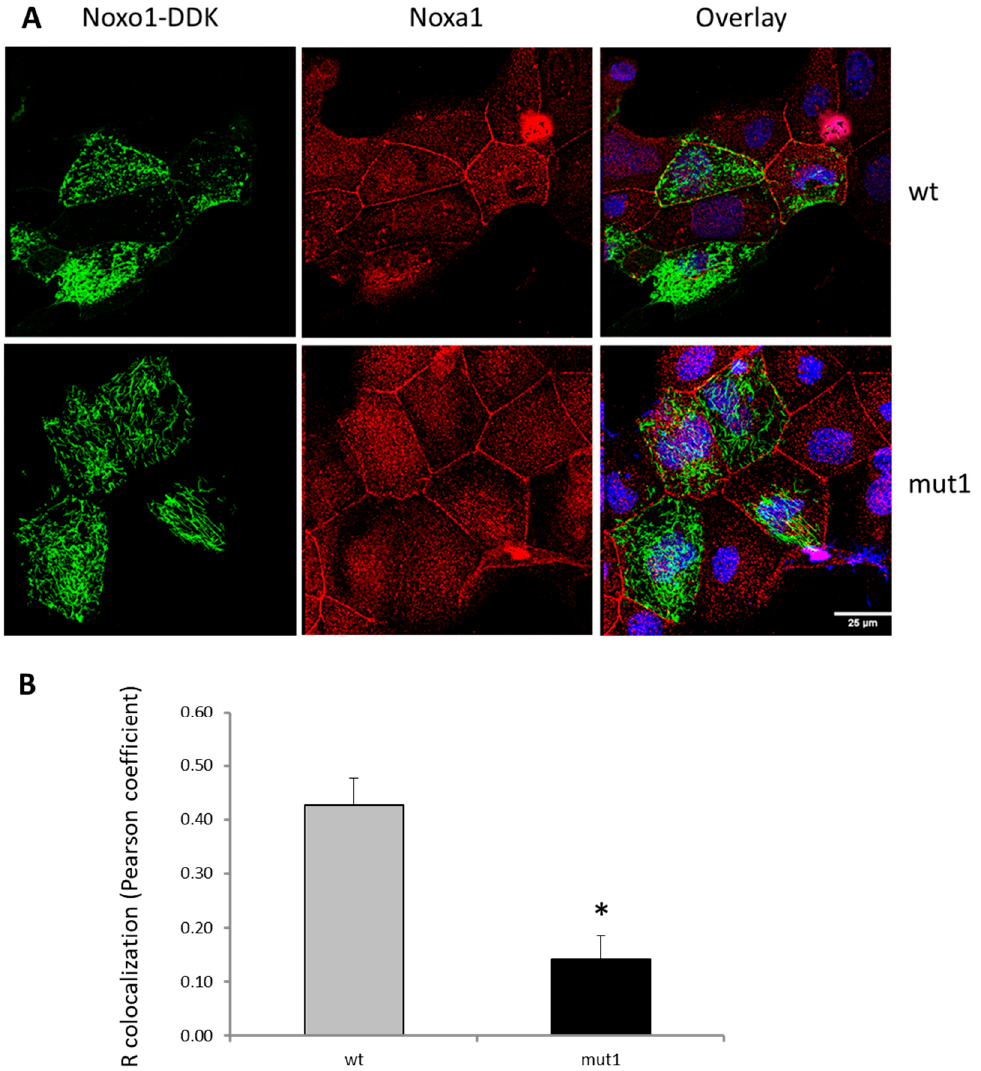
Figure 5. Effect of mut1 D-Box mutation on the Noxa1/Noxo1 interaction in CaCo-2 cells. ( A ) Fluo- rescence image of endogenous Noxa1 protein and overexpressed Noxo1-DDK. Zeiss 40x oil Zoom1. Both WT Noxo1-DDK and mut1 Noxo1-DDK did not alter the membrane localization of Noxa1. Scale bar in all panels: 25 µ m. ( B ) Quantification of colocalization (R colocalization, Pearson coefficient) of fluorescence signal from Noxo1 (wt or mut1) and Noxa1 in Caco2 cells (N = 21 ROI), * p < 0.05). To identify whether Noxo1 is distributed in different cellular compartments that would have different behaviors depending on the lysis buffer, we used a cell fractionation kit and also performed cell lysis in buffers using different types of